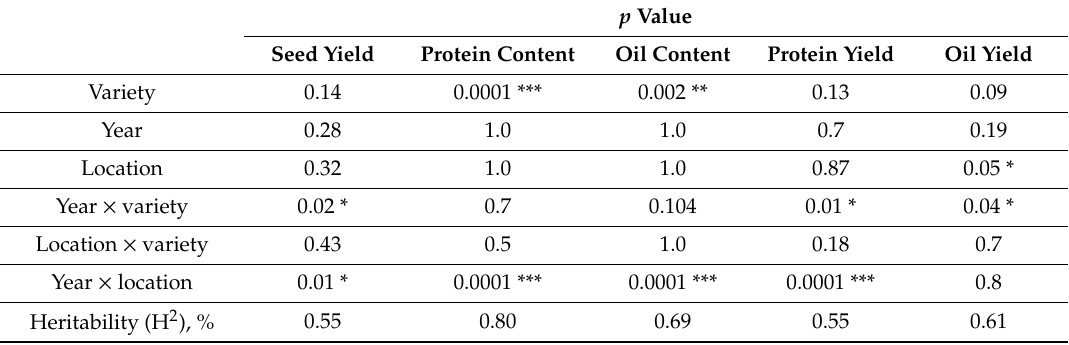
Table 4. Analysis of variance (based on Equation (1)) and heritability (Equation (3)) for seed yield and quality over five locations and two trial